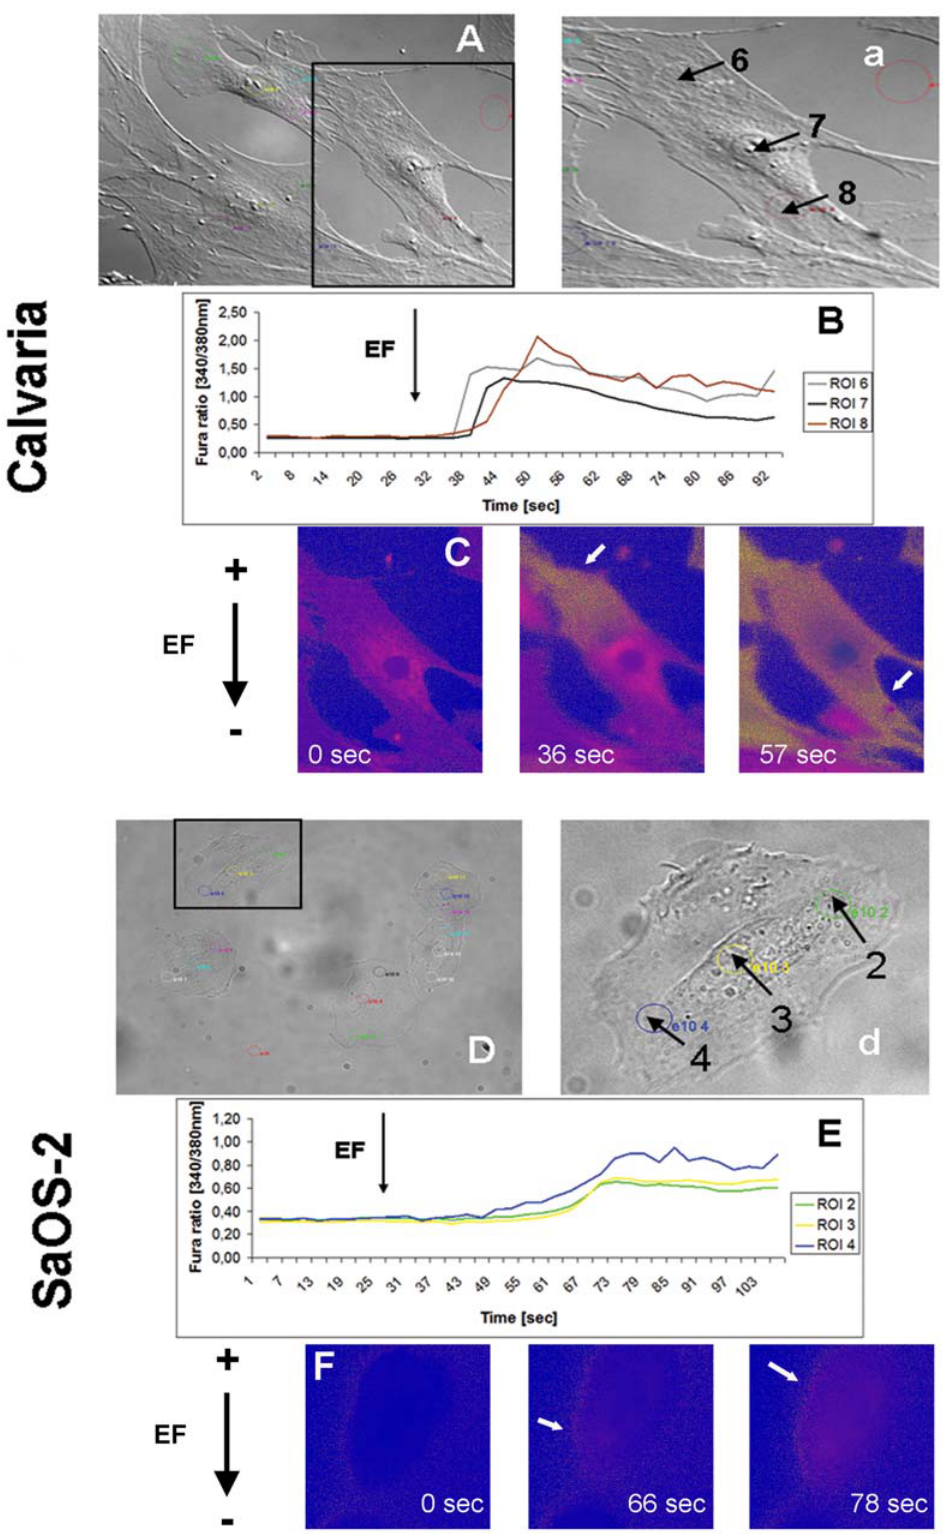
Figure 5. Local and opposite Ca 2 + initials in Fura-loaded calvaria and SaOS-2 cells exposed to strong dcEF (14 V/cm). (A,a) and (D,d) DIC images of calvaria and SaOS-2 cells with ROIs within colored circles. (B) One-cell Fura kinetics representing the sequential elevation of [Ca 2 + ] i first at anode-facing side (ROI 6, grey circle) and its propagation through the cell (ROI 7, black circle) to the cathode-facing side (ROI 8, dark red circle) of a calvaria cell. (E) The same pattern but opposite direction in a SaOS-2 cell. (C,F) False color time-lapse frames showing the contrary initiation and propagation (white arrows) of [Ca 2 + ] i elevation in calvaria and in SaOS-cells. 15–17 cells from a total of 22–23 were scored from 6–10 independent experiments. doi:10.1371/journal.pone.0006131.g005 PLoS ONE | www.plosone.org